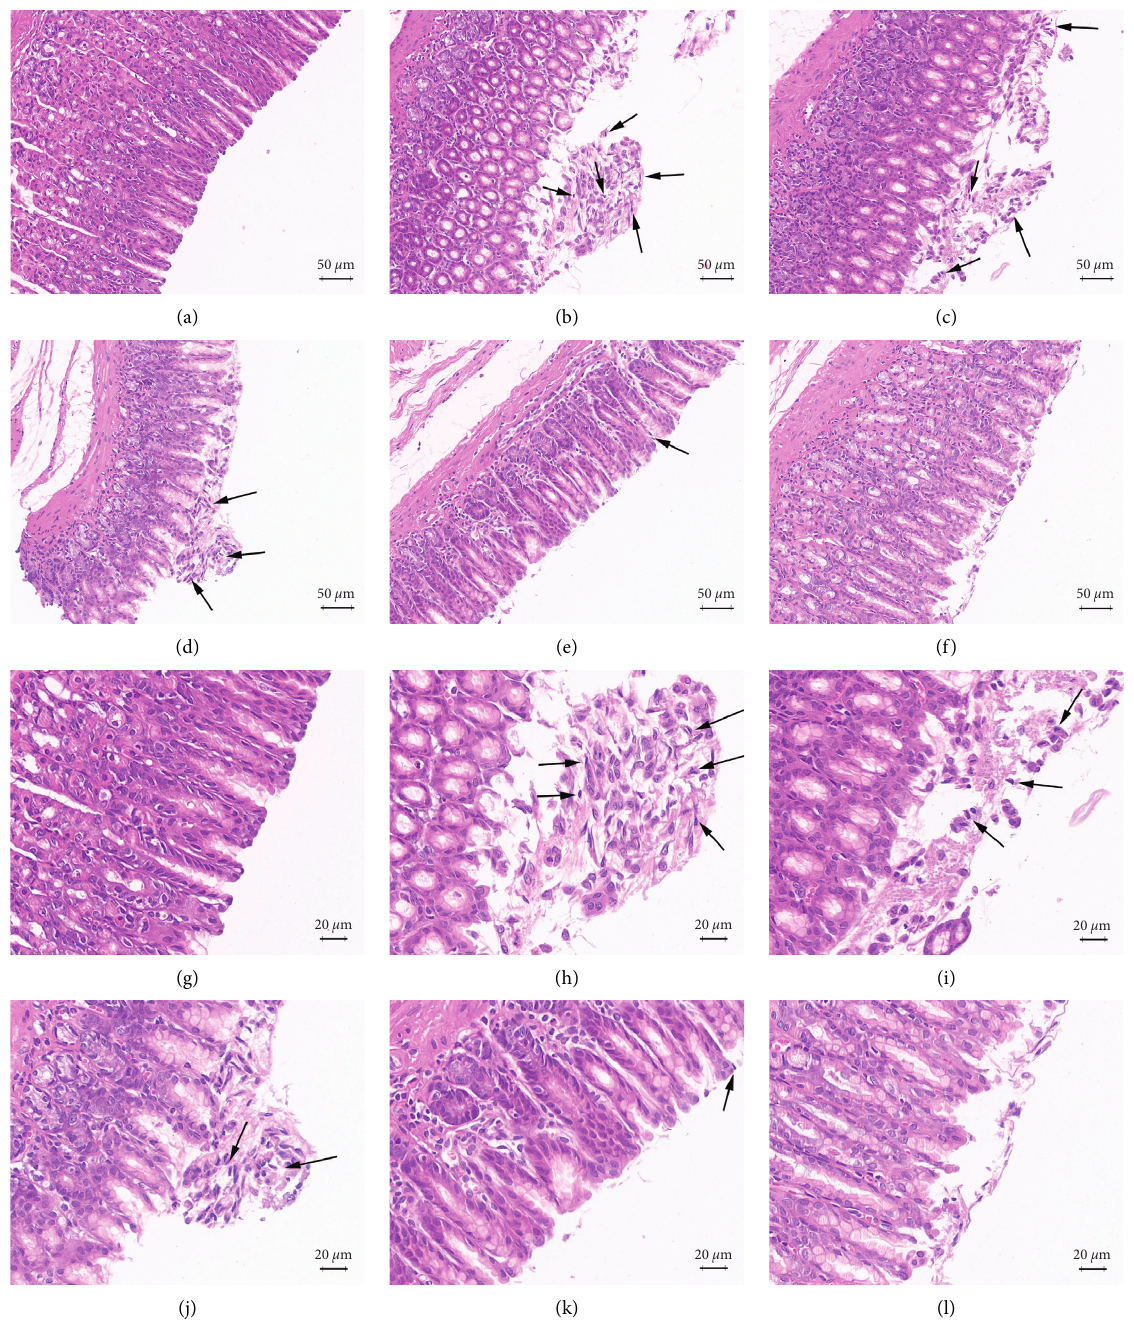
Figure 1: ZJP affects gastric histopathology in CAG rats. (a) Control group. (b) Model group. (c) 0.63g/kg ZJP group. (d) 1.26g/kg ZJP group. (e) 2.52g/kg ZJP group. (f) Omeprazole group (HE staining, × 200 magnification). (g) Control group. (h) Model group. (i) 0.63 g/kg ZJP group. (j) 1.26g/kg ZJP group. (k) 2.52g/kg ZJP group. (l) Omeprazole group (HE staining, × 400